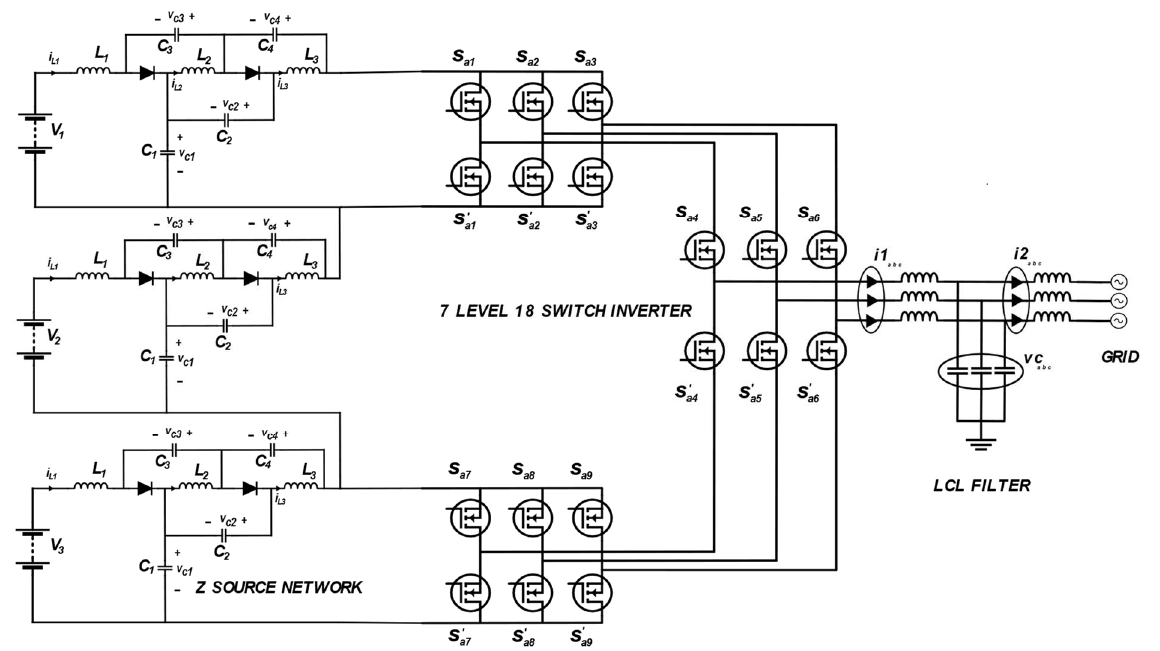
Figure 1. Circuit configuration of MCAEB qZSI topology.